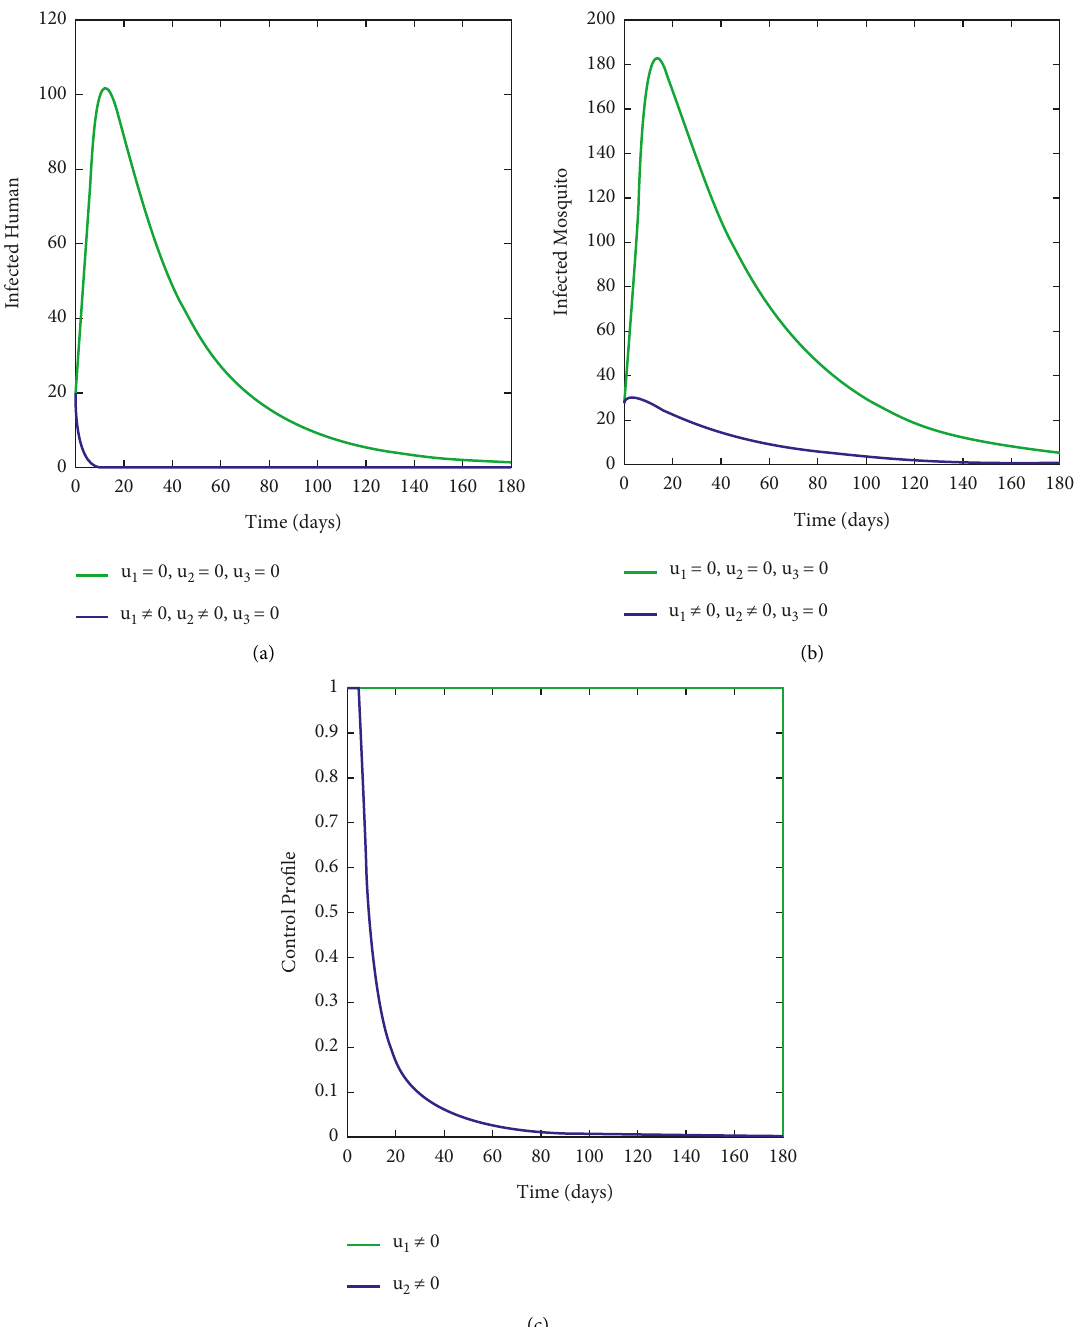
Figure 2: Simulation results showing the use of (a) treated bed net ( u , u ≠ for u 1 2